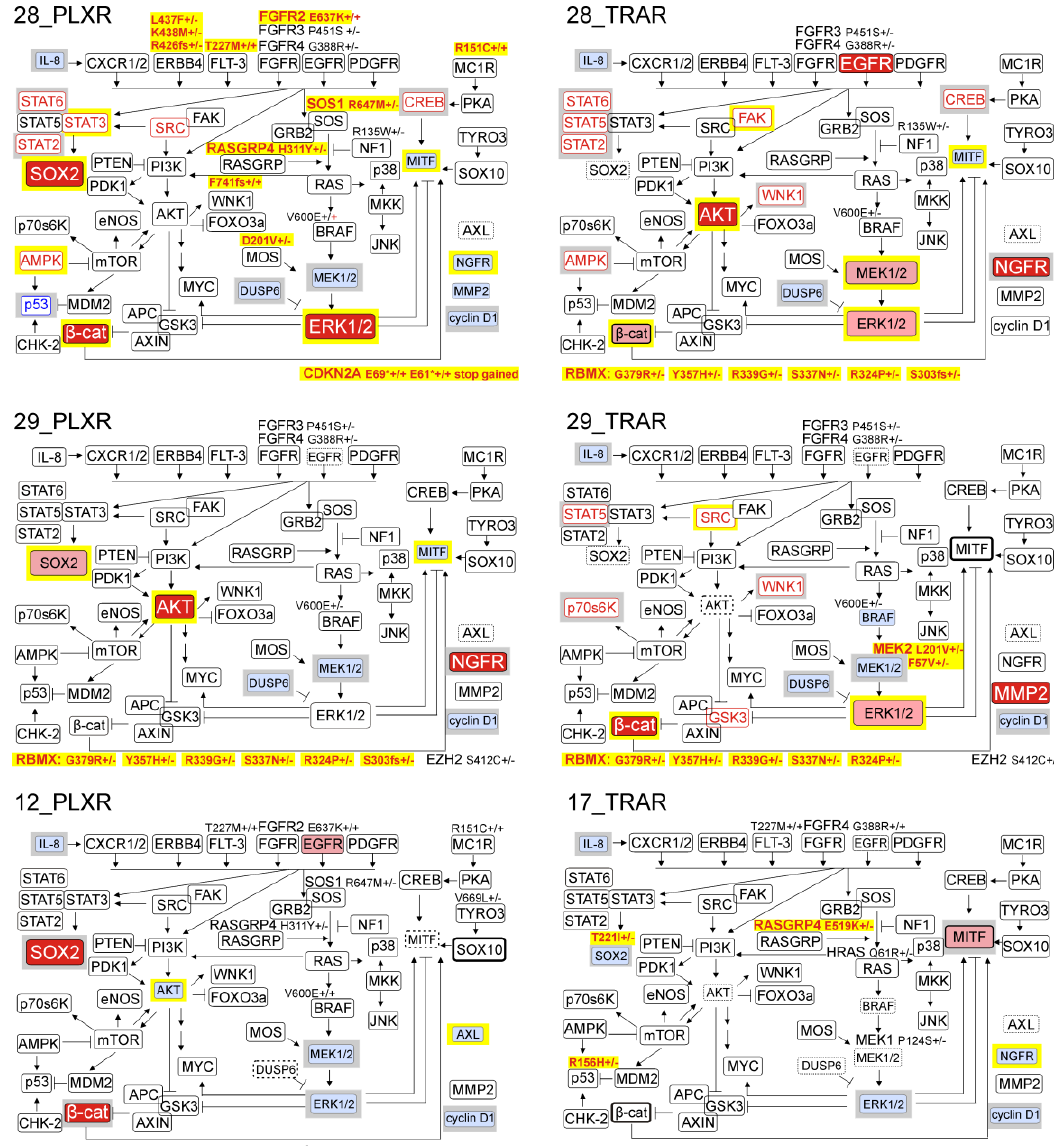
Figure 7. Diverse patterns of resistance showing patient- and drug-specific di ff erences between drug-naïve and drug-resistant melanoma cells. The profiles summarizing alterations in the major signaling pathways were prepared for selected cell lines. The scheme showing changes in all resistant cells lines along with methods of data acquisition is provided as Figure S2. Color coded overview comparing investigated cell lines in terms of di ff erences between drug-naïve and drug-resistant cells. Red / pink, strong / weak enhancement; blue, inhibition; red / blue frame and font, enhancement / inhibition shown only in phospho-profiling; dotted frame smaller in size, weak level / activity in drug-naïve cells; bold frame, high level / activity in drug-naïve cells; mutations acquired by resistant cells are marked in red, and those already present in drug-naïve cells are marked in black. Changes, which were already induced during immediate response to drugs are in the grey background, whereas changes unique for resistant cells (including mutations) are in the yellow background. Figure S1: IL-8 levels in the culture media were assessed after 24 h by using ELISA. Figure S2: Diverse patterns of resistance showing patient- and drug-specific di ff erences between drug-naïve and drug-resistant melanoma cells. Table S1: Mutation status of genes associated with the regulation of signaling pathways, including MAPK, PI3K/AKT and cell cycle based on the KEGG PATHWAY databases, as well as receptors and transcription